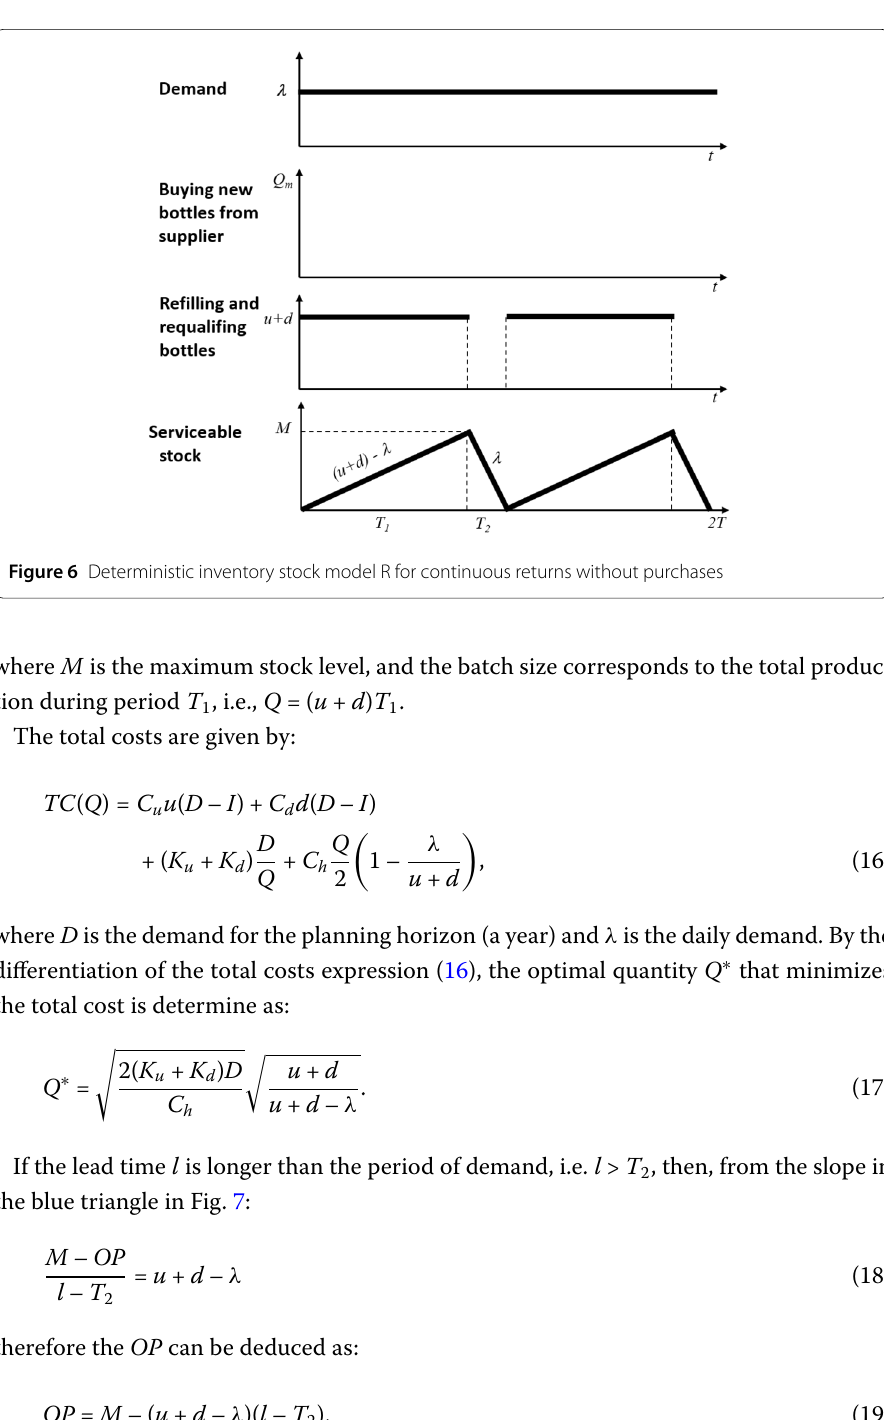
Figure 6 Deterministic inventory stock model R for continuous returns without purchases